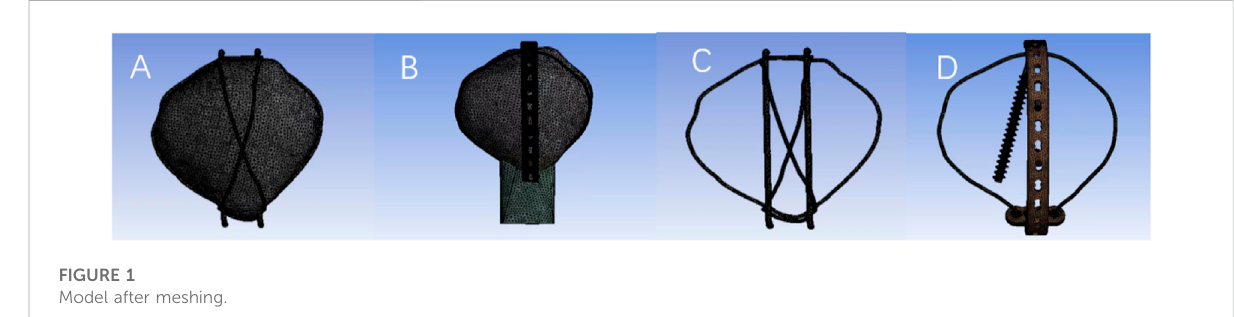
FIGURE 1 Model after meshing.